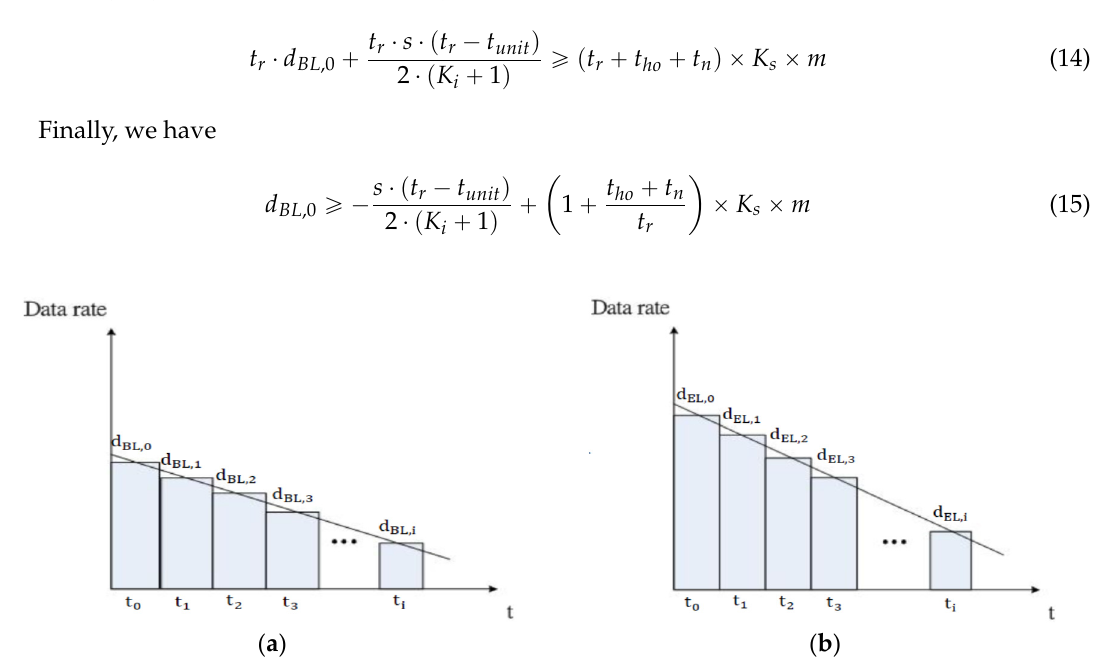
Figure 3. The data rate of ( a ) BL and ( b ) EL under degrading RSRP.